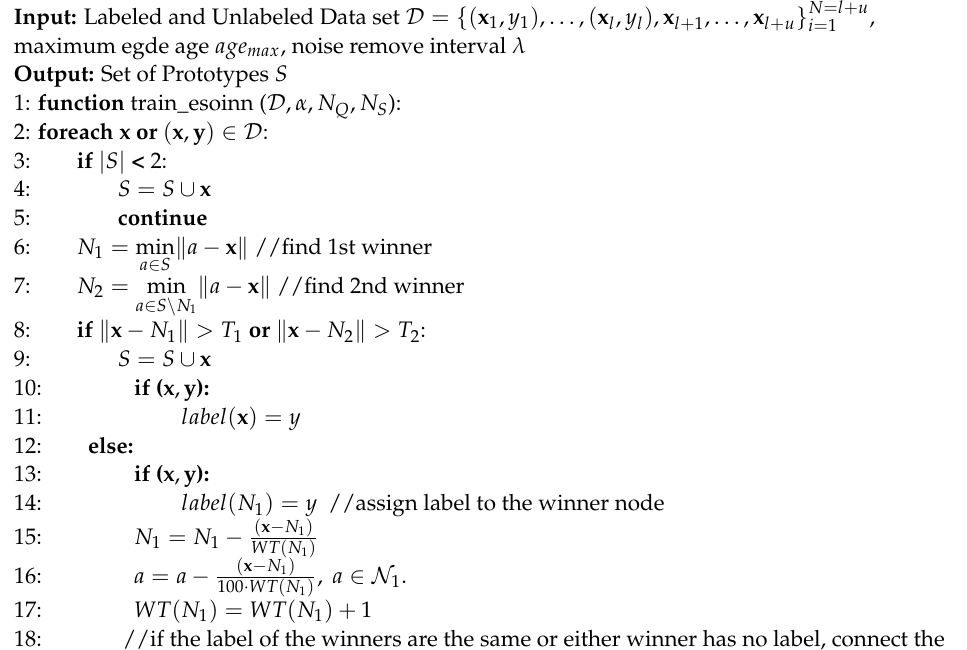
Algorithm 2. Modified Enhanced Self-Organizing Incremental Neural